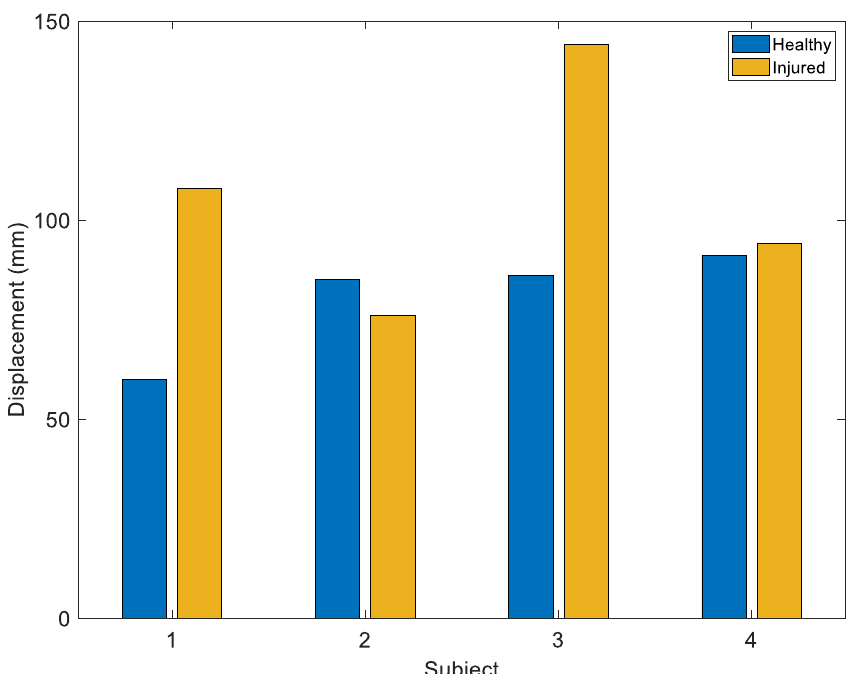
Figure 14. Maximum strain of Stretch Sensor 2 during pivot shift test.